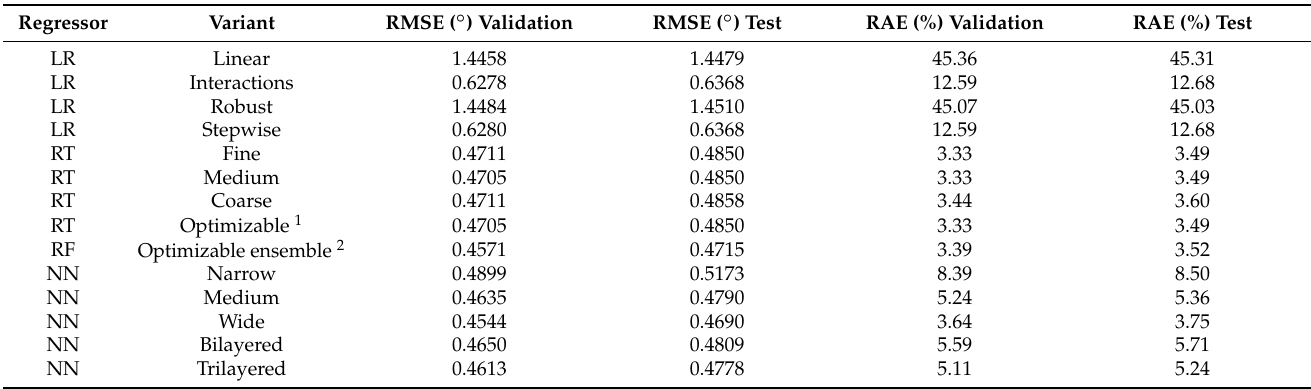
Table 3. Results of training the regressors considering (cid:101) normal and the rotation axis between normals with 5-fold